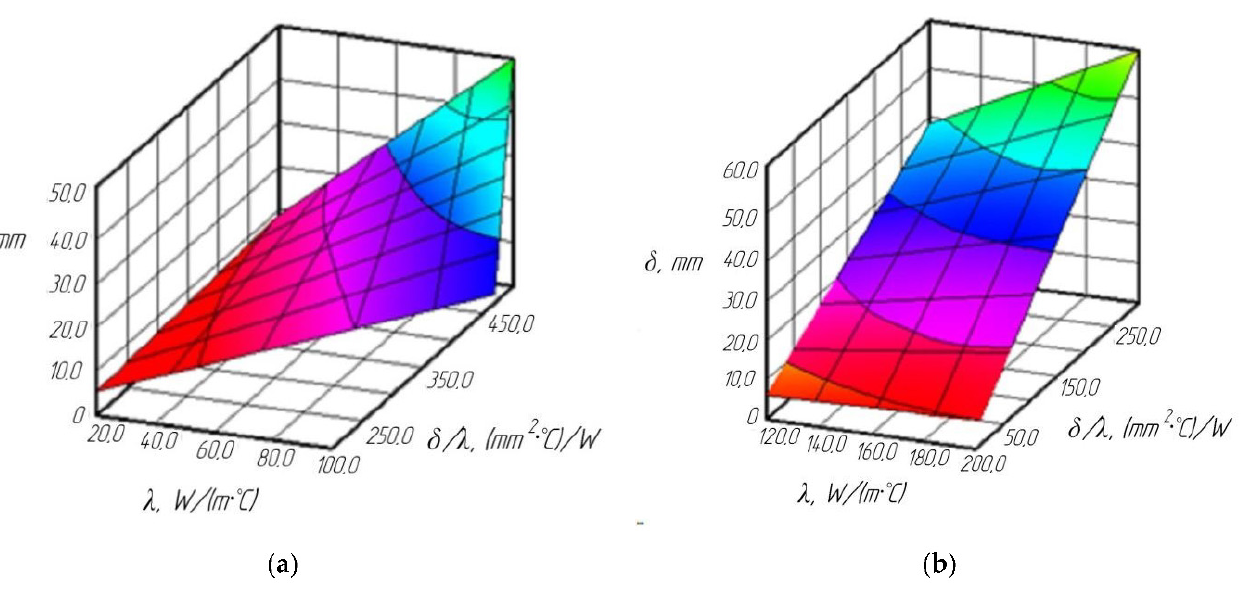
Figure 4. Changes in thermal resistance ( δ / λ ) of brake discs depending on their thickness ( δ ) and thermal conductivity coefficients of the materials ( λ ), varying within: ( a ) 20–100 W / (m 2 ° С ); ( b ) 120–200 W/(m 2 ° С ).